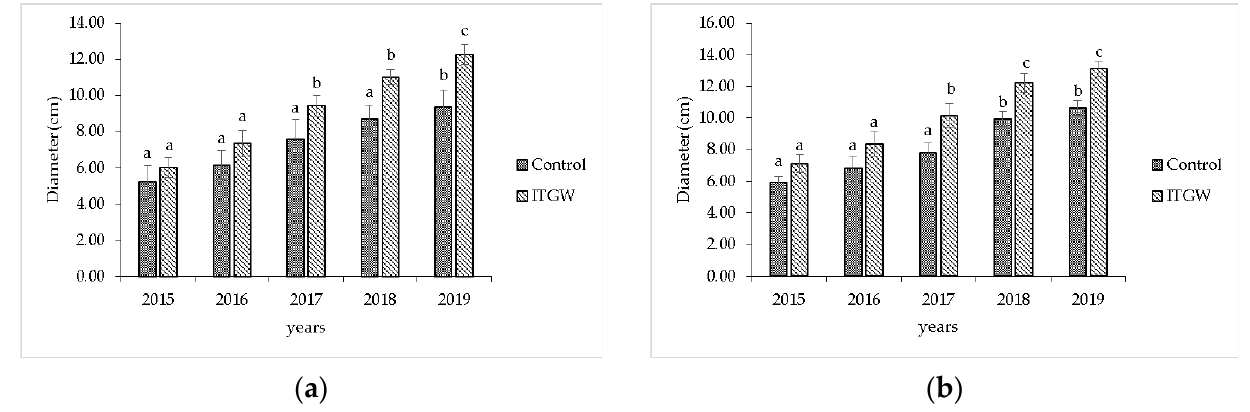
Figure 3. Variation of the diameter (D) of the two varieties of olive trees during the period 2015–2019: ( a ) Chétoui; ( b ) Picholine.